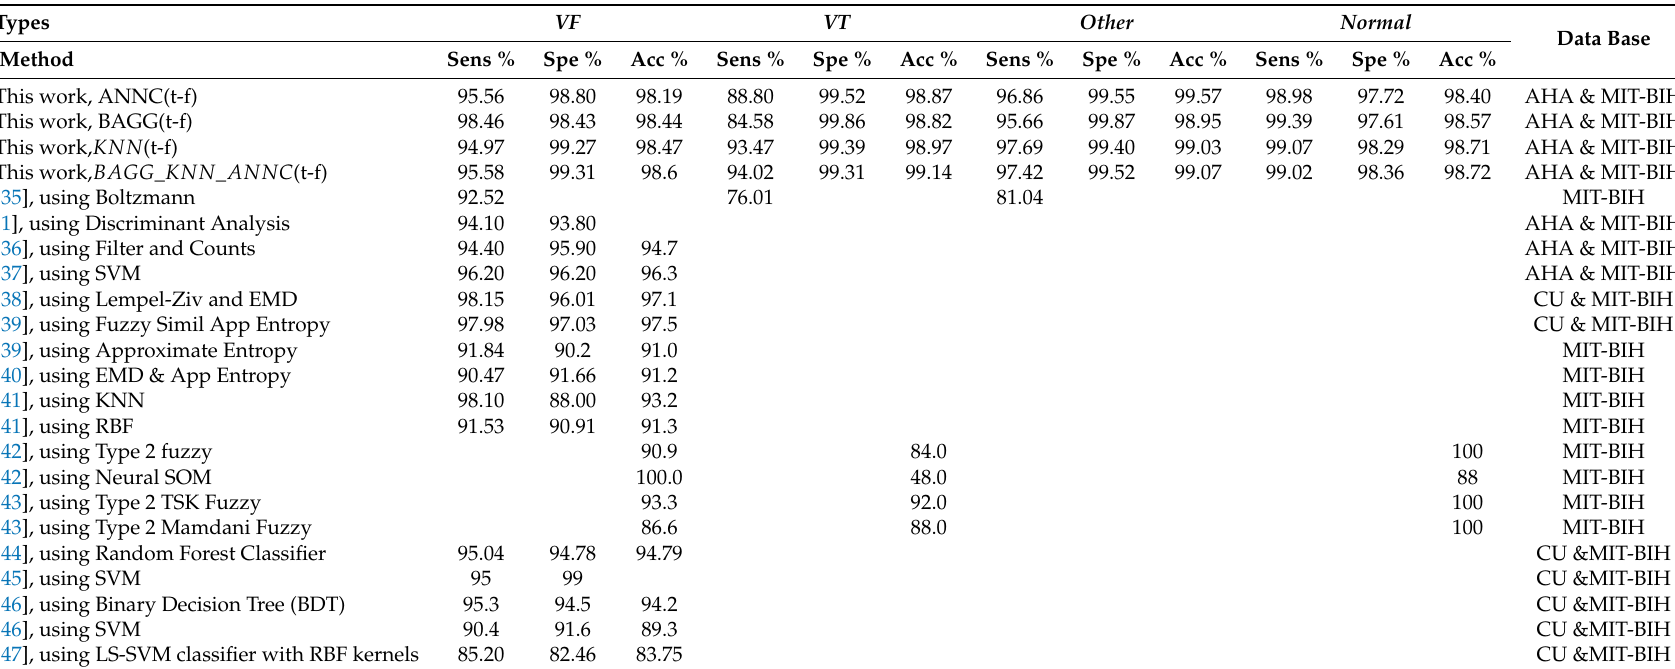
Table 18. Performance evaluation of VF detection algorithms for comparison with the four analyzed classifiers in this